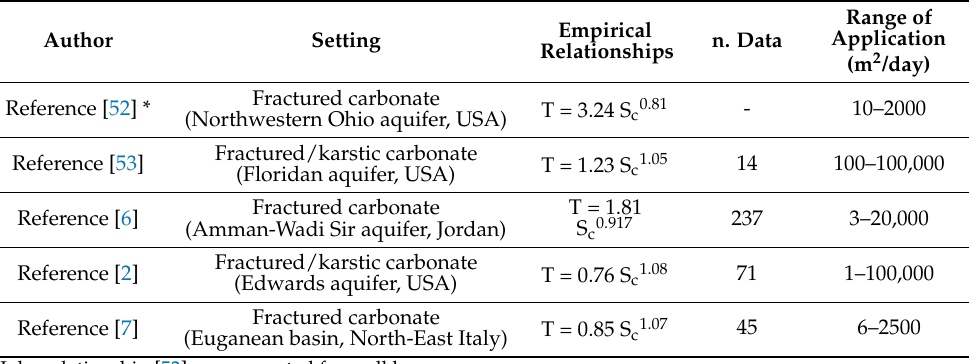
Table 2. Summary of empirical relationships between well specific capacity (S c ) and transmissivity (T) of fractured and karst aquifers. The unit of all equations is m 2 /day.